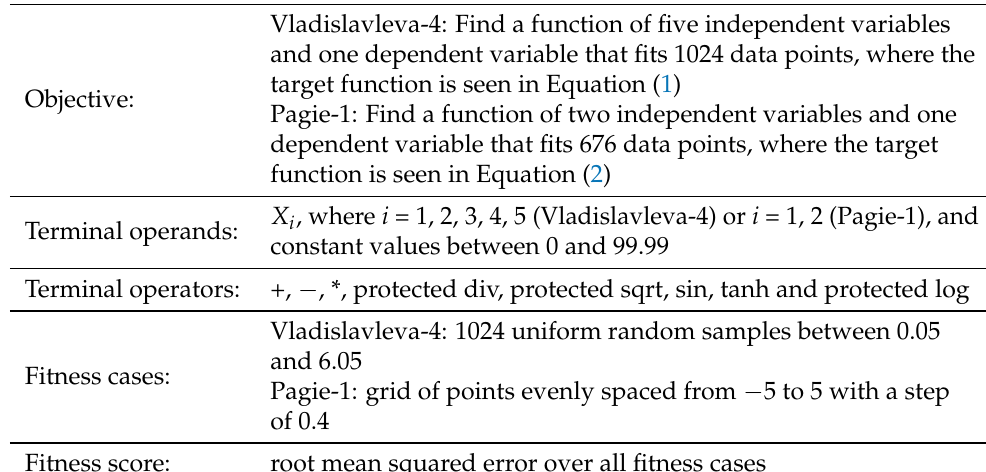
Figure 3. Grammars used for all experiments. Items in bold are non-terminals. Table 2. Symbolic regression